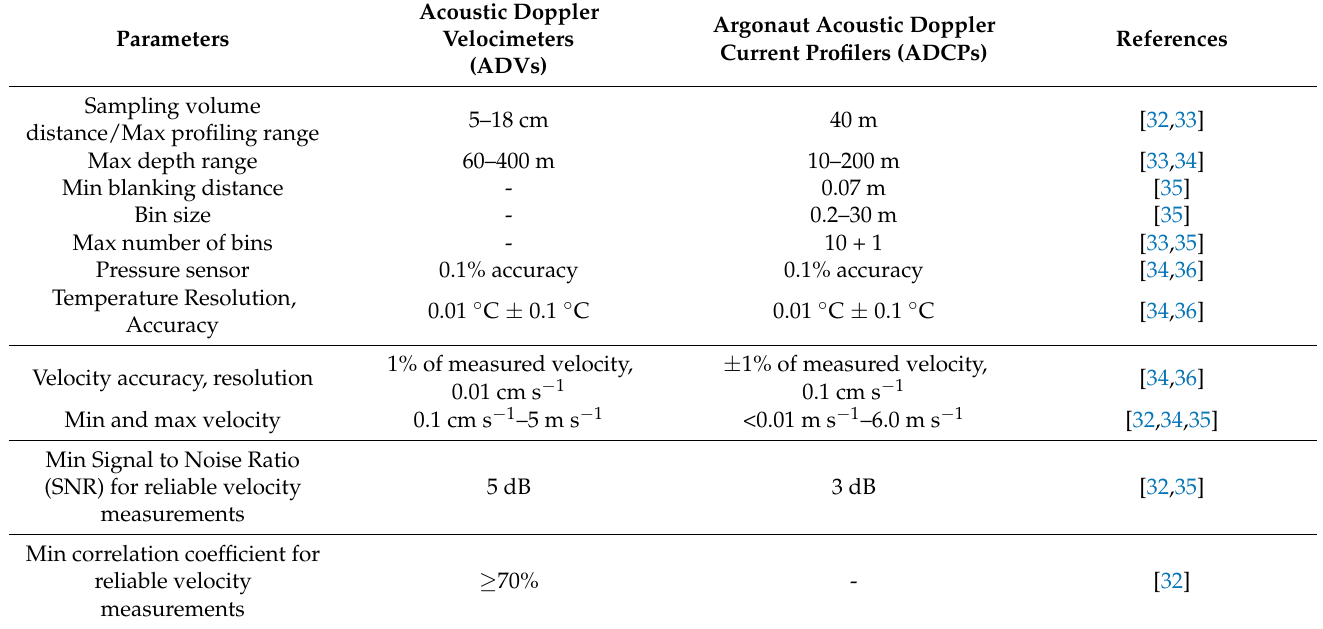
Table 1. Characteristics of acoustic devices manufactured by SONTEK—a Xylem